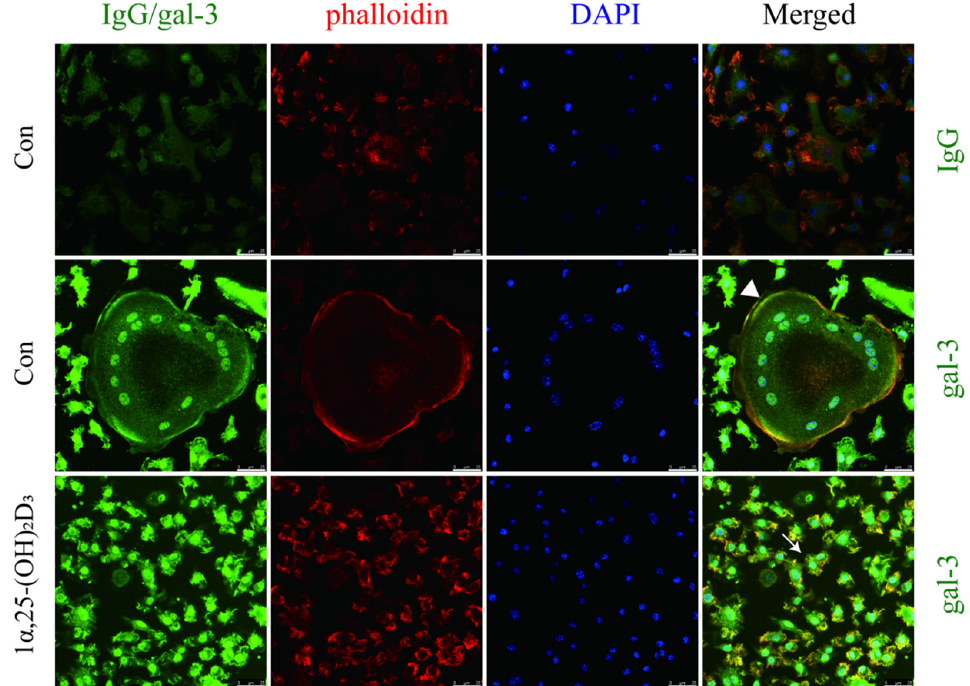
Figure 4. Immunofluorescence showed the distribution and expression of gal-3 after the treatment of 1 α ,25-(OH) 2 D 3 . Gal-3 mainly distributed in the nuclei (cyan) and cell membranes (yellow) of OCs (marked by white triangle) and in the whole cell of OCPs (white arrows). Gal-3 protein distribution was regulated by 1 α ,25-(OH) 2 D 3 . In non-merged images, green indicates gal-3, red indicates F-actin, and blue indicates nuclei. Bars = 25 μ m.